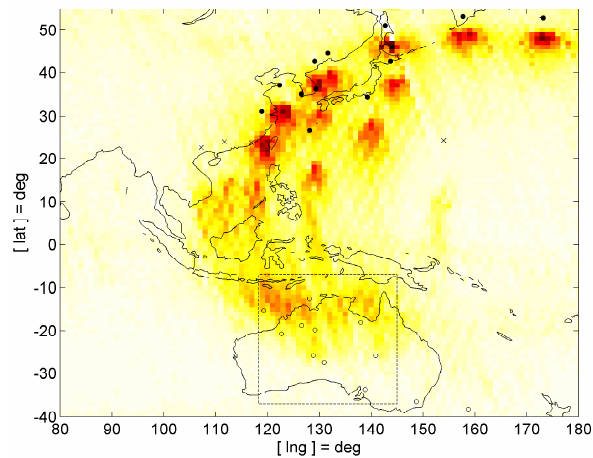
Fig. 4. Some LORAN transmitters in East Asia (dots) emit radio waves which are observed as a diffuse illumination of the plas- masphere northward of their corresponding geomagnetic conjugate locations in Australia and Southeast Asia (circles in dashed box). These conjugate locations correspond to LORAN transmitters at extremely low geomagnetic latitudes ( L < 1.36). The observed dif- fuse luminosity suggests that the propagation along the geomag- netic field lines spreads the radio wave energy over large spatial distances of ∼